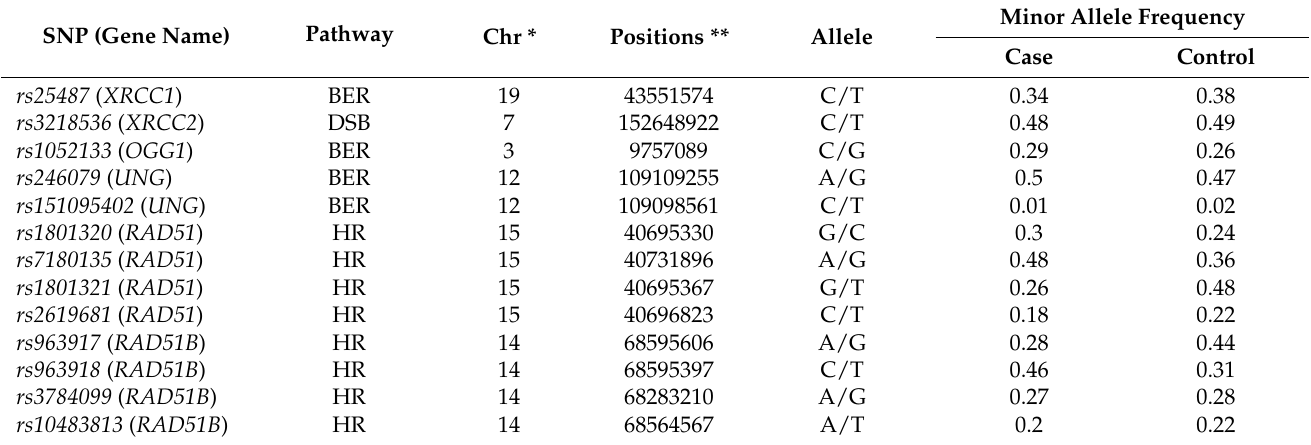
Table 3. Basic information and allele frequencies of the 28 selected